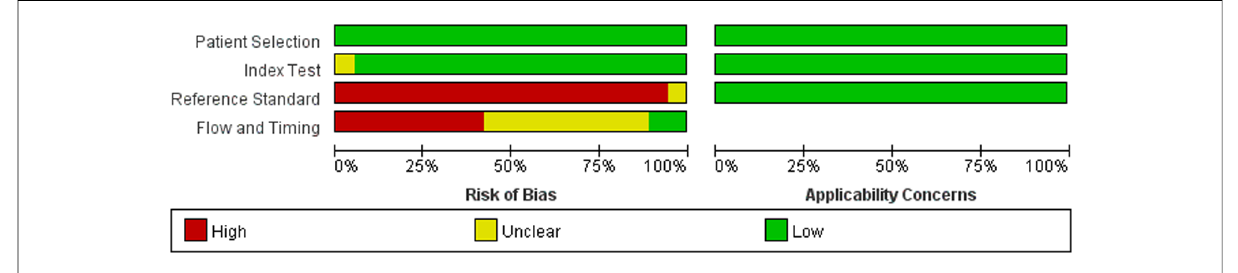
Figure 2 Risk of bias and applicability concerns